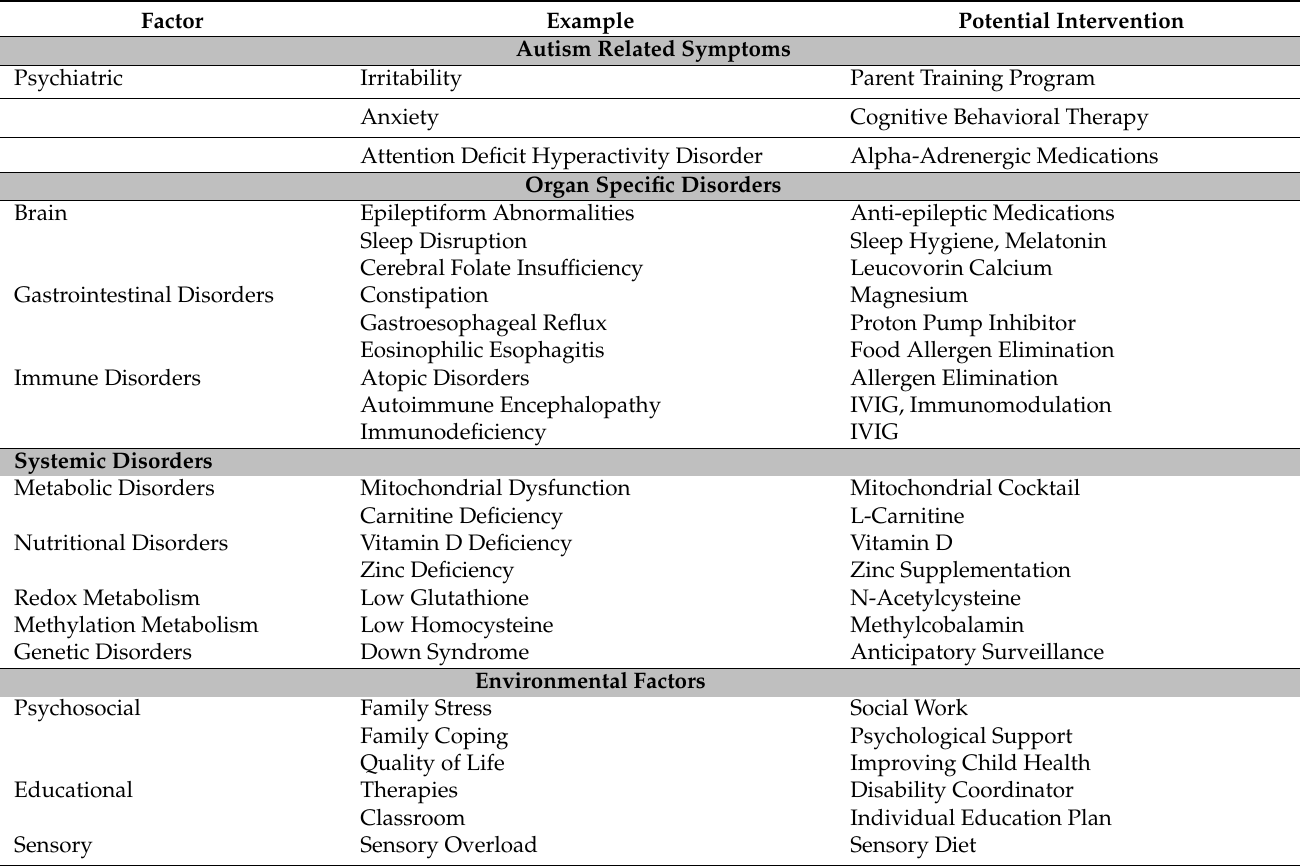
Table 3. Examples of Potentially Treatable Conditions Associated with Autism Spectrum